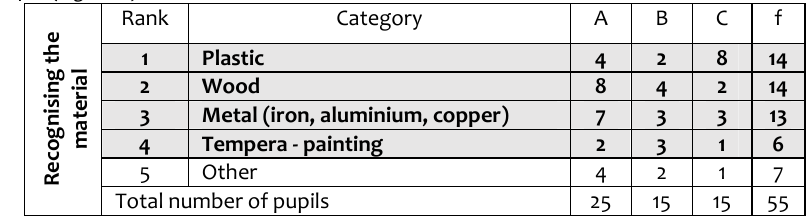
Table 12: Ranking order of answers regarding understanding and interpretation of the